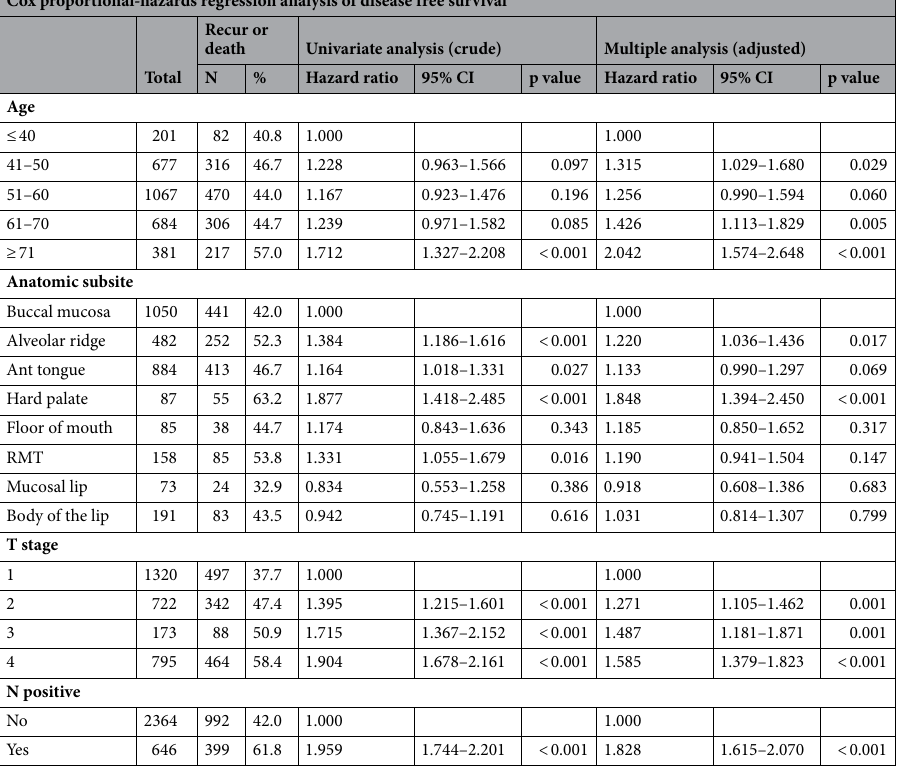
Table 3. Multiple Cox proportional hazards regression analysis of disease-free survival. Follow-up time: from OSCC diagnosed to recur, death, or 2019–12-31. RMT retromolar trigone.